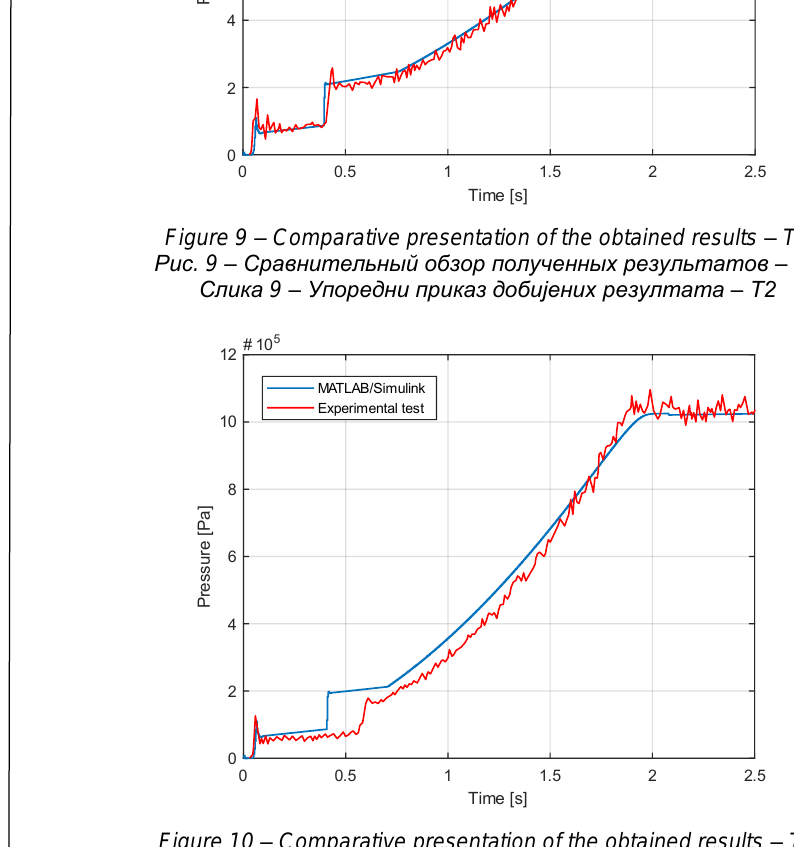
Figure 10 – Comparative presentation of the obtained results – T3 Рис. 10 – Сравнительный обзор полученных результатов – Т3 Слика 10 – Упоредни приказ добијених резултата –